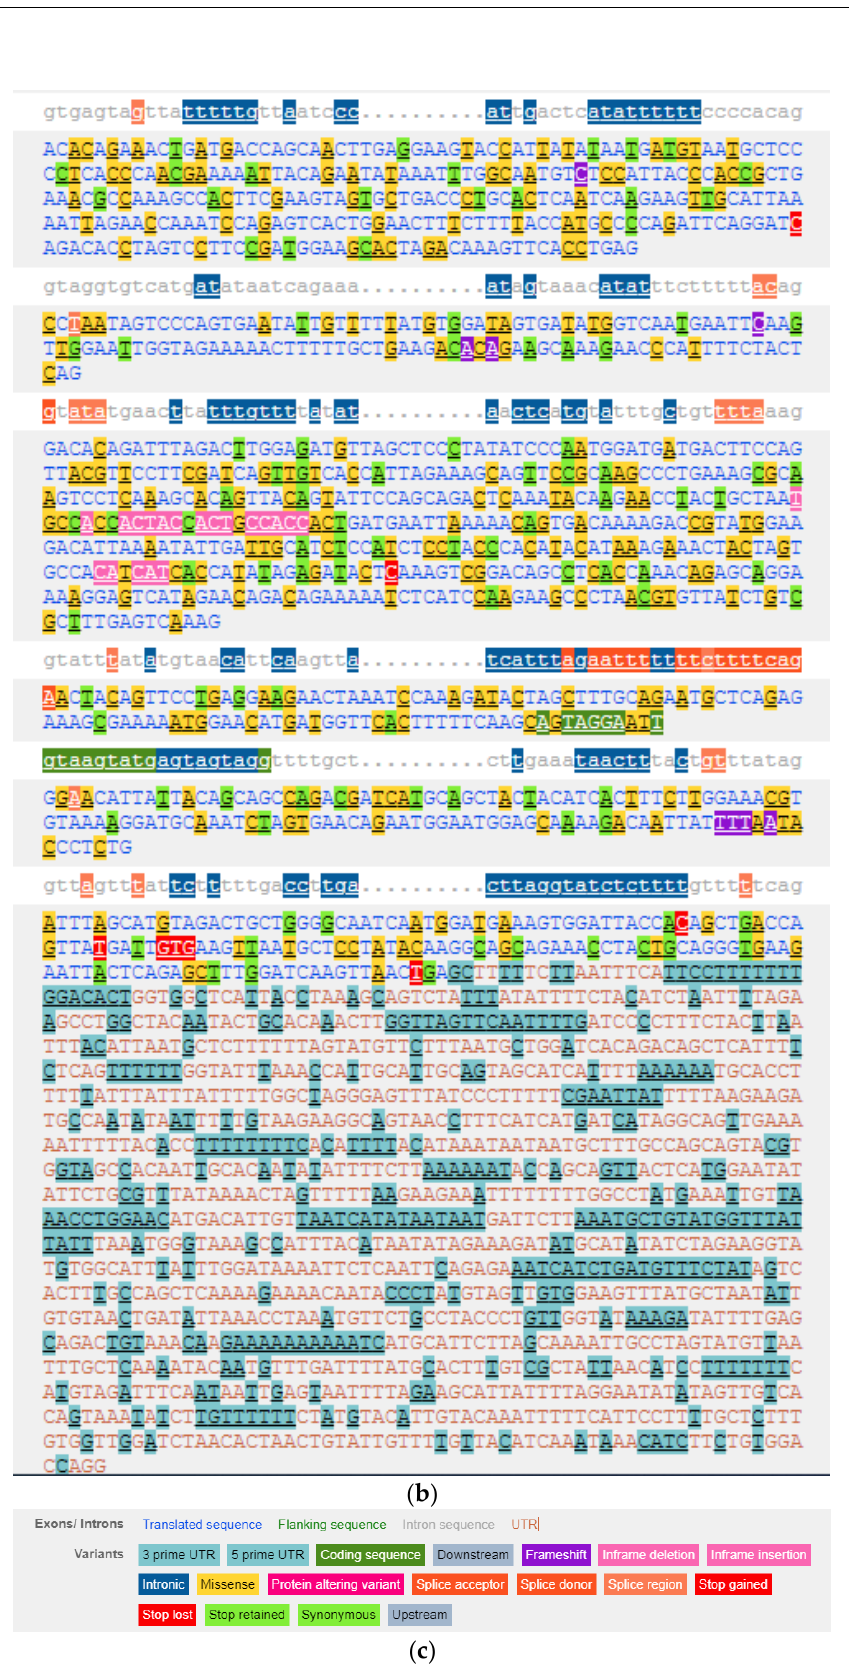
Figure 3. Human HIF1A gene structure and genetic variants. ( a ) Gene sequence from 5 ′ UTR/exon 1 to exon 9. ( b ) HIF1A gene sequence from intron 9 to exon 15/3 ′ UTR. Partial sequences of introns are shown; start and end. ( c ) Color legend. The figures were obtained from the Ensembl genome browser.